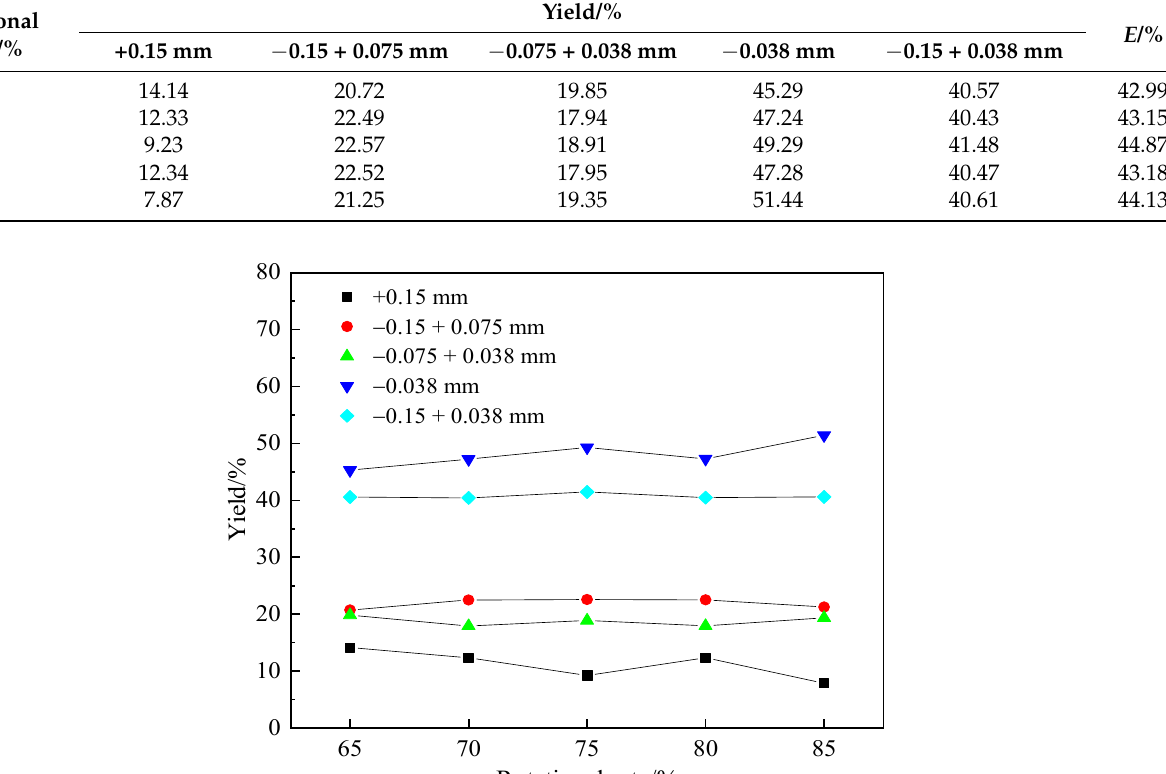
Table 8. Particle size composition of grinding product at different grinding times.